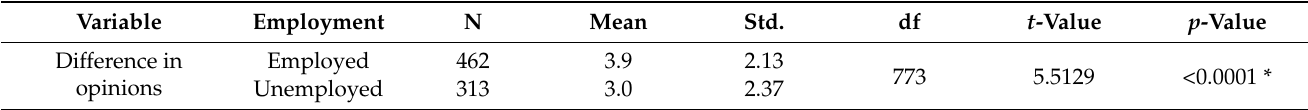
Table 4. Difference in motivational factors influence for purchasing luxury brands (by employment).